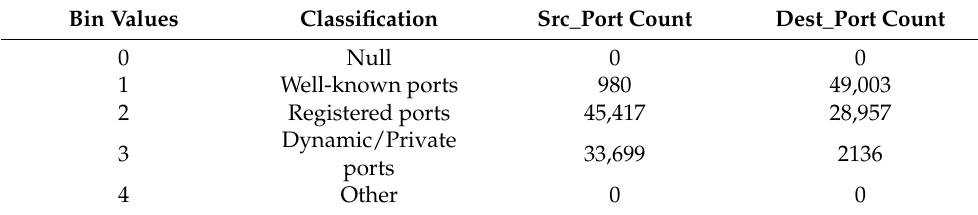
Table 11. Differences between bin values for src_port vs. dest_port [26]. Bin